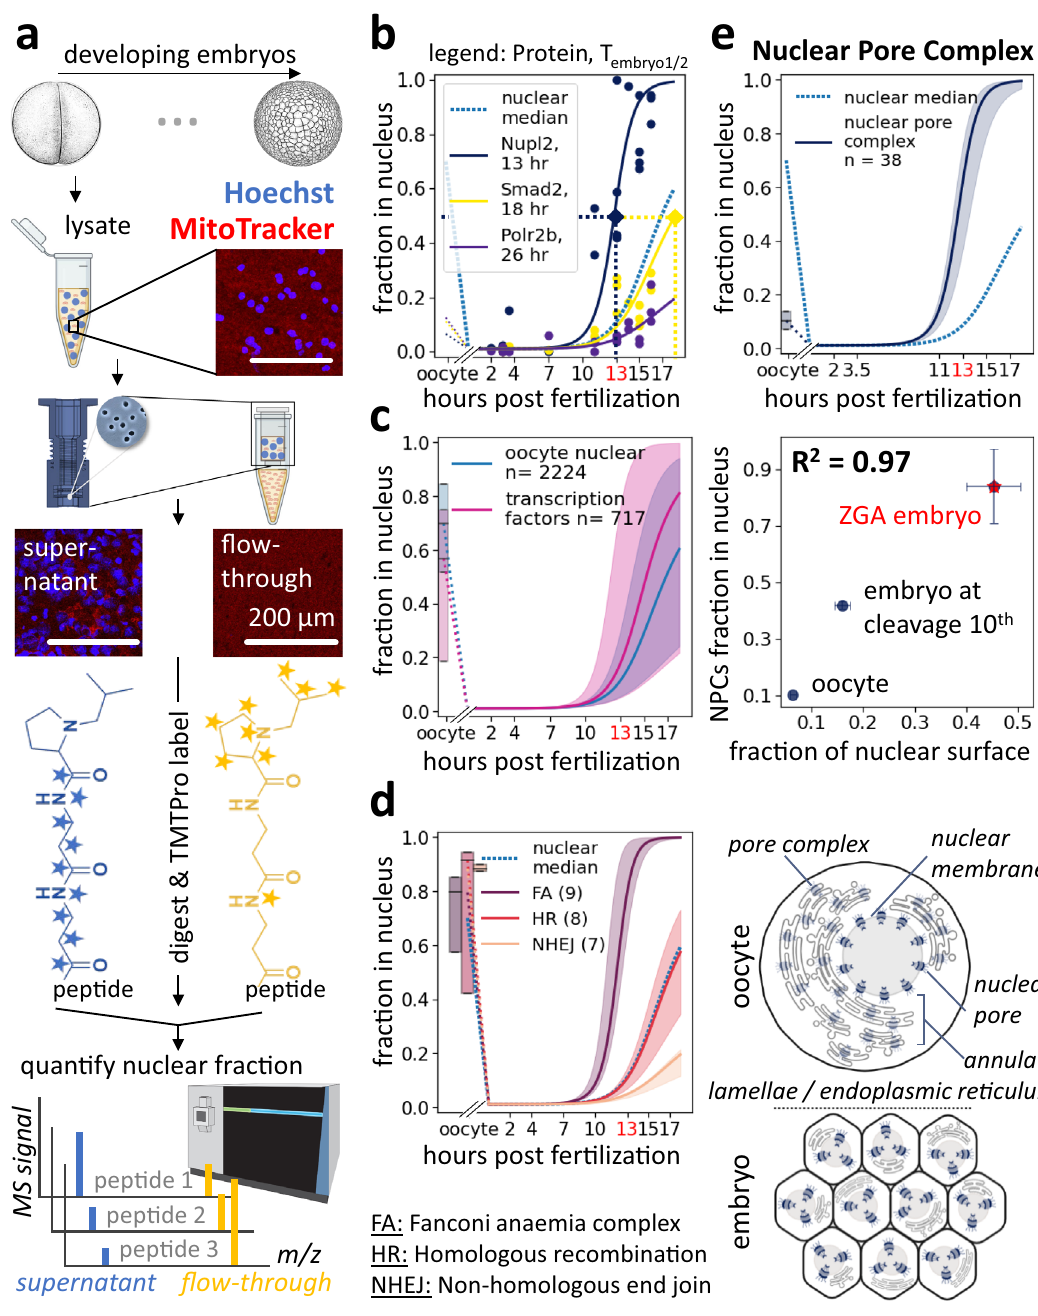
Fig. 2 | Quanti fi cation of nucleocytoplasmic partitioning during early devel- opment. a Assay to quantify nucleocytoplasmic partitioning via multiplexed pro- teomics. Embryonic lysate, developed at 16°C, was collected at various stages: nucleiwereenrichedby fi ltrationthroughmembranesofde fi nedporesizes.Shown are example epi fl uorescence images of lysate, supernatant, and fl ow-through stained with Hoechst (blue) and MitoTracker (red). Supernatant and fl ow-through fractions were digested into tryptic peptides, labeled with isobaric tags, and sub- jected to accurate multiplexedproteomic analysis. Xenopus illustrations © Natalya Zahn (2022) 86,95 . b Nucleocytoplasmic partitioning quanti fi cation for three exam- ples. Dots indicate measured fraction of each protein in nuclei. Solid lines indicate fi t sigmoids. Blue dashed line indicates median fi t from all nuclear proteins. c Quanti fi cation of time-dependent nuclear fraction for ~2k nuclear proteins and ~600 transcription factors (TFs) 20,71,96 . Solid line indicate the median and shaded area50%spread. d , e Measurementsformultisubunitproteincomplexes.Solidline indicates the median and shaded area 50% spread. d DNA repair complexes enter embryonic nuclei at various times, yet their subunits enter simultaneously.